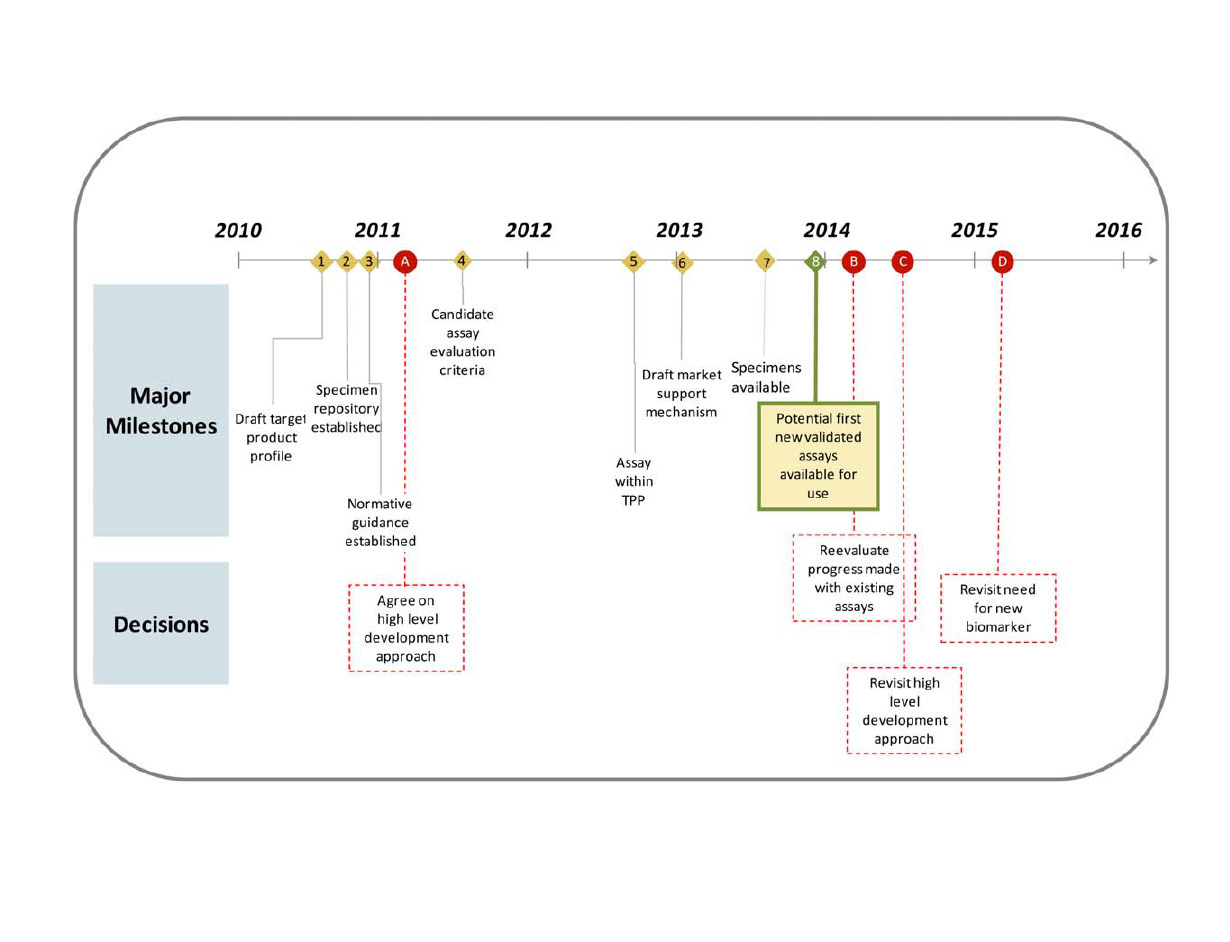
Figure 1. Key milestones and decision points in the critical path over the next 5 years. Anticipated timing of major milestones (numbered diamonds with solid lines) and key decisions (red circles with dashed lines) over the next 5 years in the critical path.